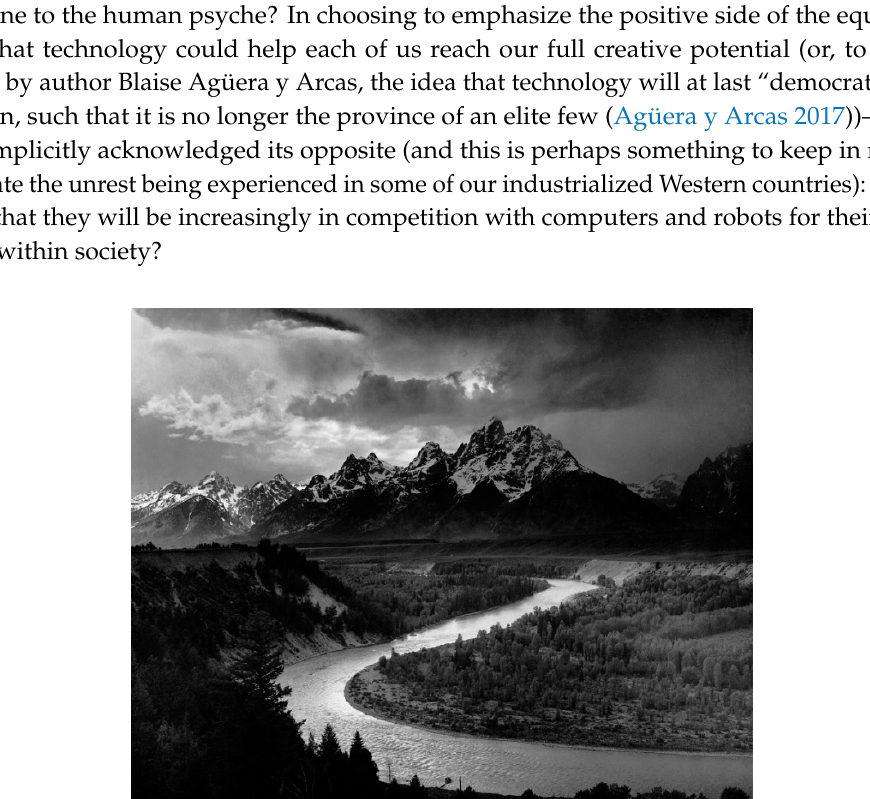
6 Or—in the original French—“une large ouverture de la sphère créative” (Bessette 2018).